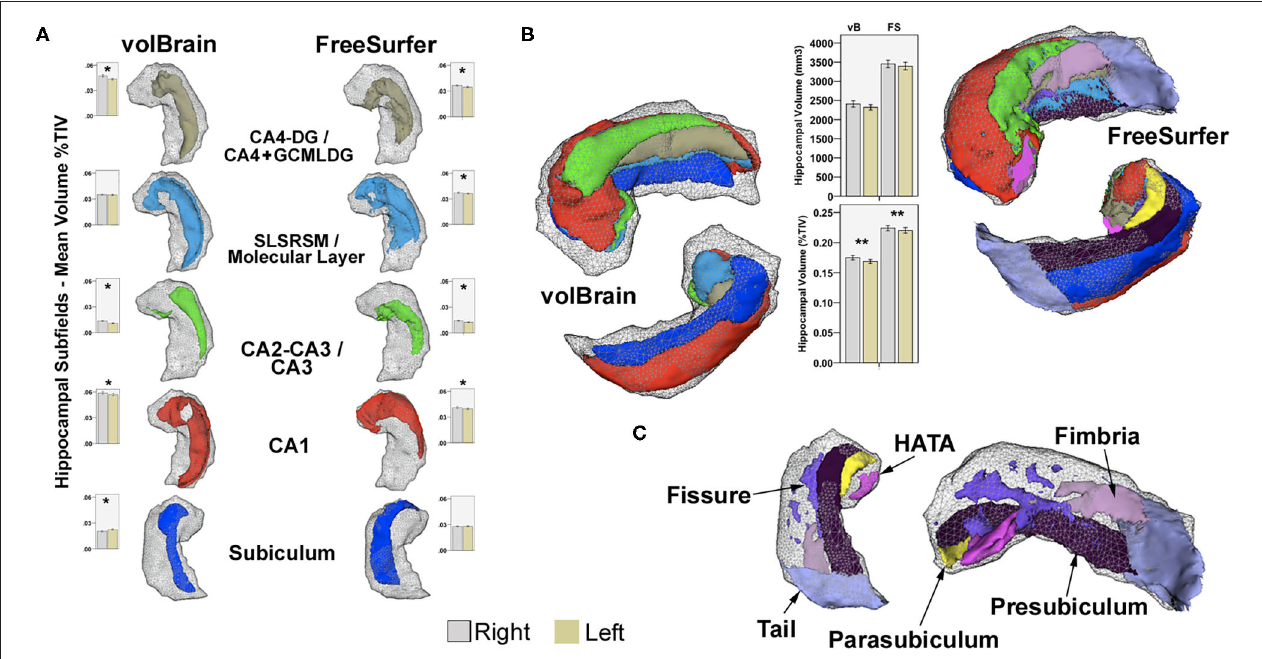
FIGURE 1 | (A) Examples of common subfield’s atlas definition using vB and FS. Boxplots represent mean volumes as percent of TIV and whiskers the 95% confidence interval for the HC group. (B) Right hippocampal 3D models for the same subject, constructed using all subfields from both methods in 3D Slicer 2 ; boxplots represent mean hippocampal volumes for left and right hippocampi in HC expressed in mm3 and in percent of TIV. Upper models show anterior–superior view, and lower images represent inferior projections for comparison. Shaded gray-wireframe area embodies whole hippocampus representation created from standard FS segmentation; note reduced size of the vB model. Most noticeable subregion differences are related to the definition of the anterior and posterior extent of CA1 and posterior subiculum; more medially and dorsally extended in vB. Coincidentally, the hippocampal tail, pre-subiculum, and para-subiculum regions defined in FS represents at least partially overlapping areas between methods. Other deep internal hippocampal structures such as the molecular layer, GCMLDG, fissure, and fimbria are individually ascribed only in FS (C) . CA4-DG and CA2-CA3 subfields are jointly segmented in vB; CA4 and GCMLDF are grouped together in FS for comparison purposes. Volume differences are probably not only related to atlas definition; both approaches also show methodological discrepancies for intracranial volume computation. *Significant after Bonferroni correction. **Significant uncorrected p < 0.05. Paired-sample T -test for inter-hemispheric comparison of volumes as percent of TIV in